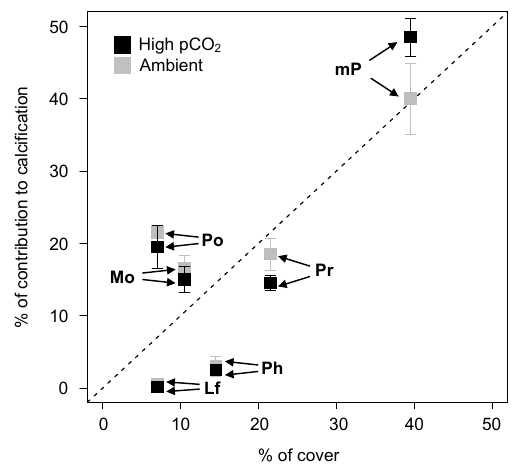
Figure 3. Relative contribution of each functional group of corals and calcifying algae to the calcification budget of communities as a function of their contribution to the planar surface area of calcifiers in the flumes. Contribution to the calcification budget was derived from the buoyant weight measurements made on each individual at the beginning and end of the 8-week incubation. The grey (am- bient condition) and black (high p CO 2 ) squares correspond to the mean ± SD specific contributions of massive Porites (mP), Porites rus (Pr), Pocillopora spp. (Po), Montipora spp. (Mo), Porolithon onkodes (Ph), and Lithophyllum flavescens (Lf). The dashed line corresponds to a contribution to the calcification budget equivalent to the planar surface areas of calcifier in the